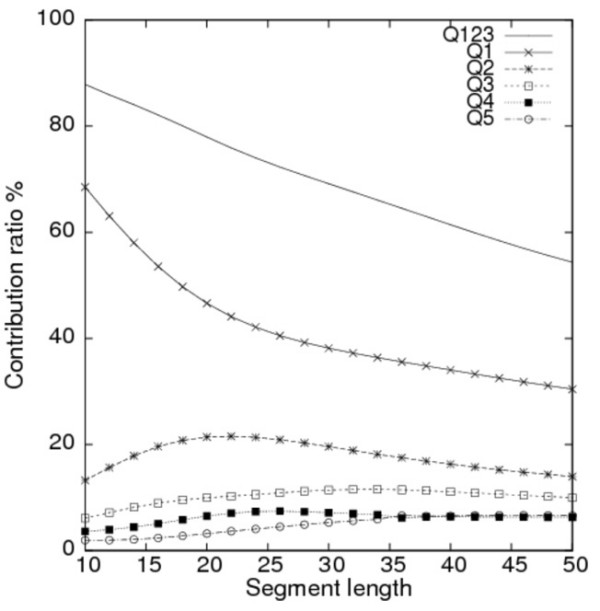
Contribution ratios for the PC axes. Contribution ratios for the first five PC axes for segment lengths of 10–50 residues are shown here. The cumulative contribution ratio for the first three PC axes (Q123, solid line with no symbol) and the individual contribution ratios of PCall1 (Q1, crosses), PCall2 (Q2, asterisks), PCall3 (Q3, squares), PCall4 (Q4, filled squares), and PCall5 (Q5, circles) are shown.